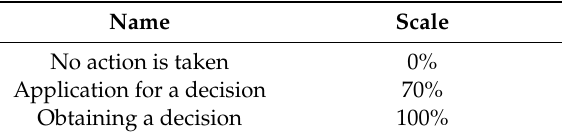
Table6. Thepercentagescaleoftheprocessofobtainingadecisiononthesitelocationofapublic-purpose line-investment project.